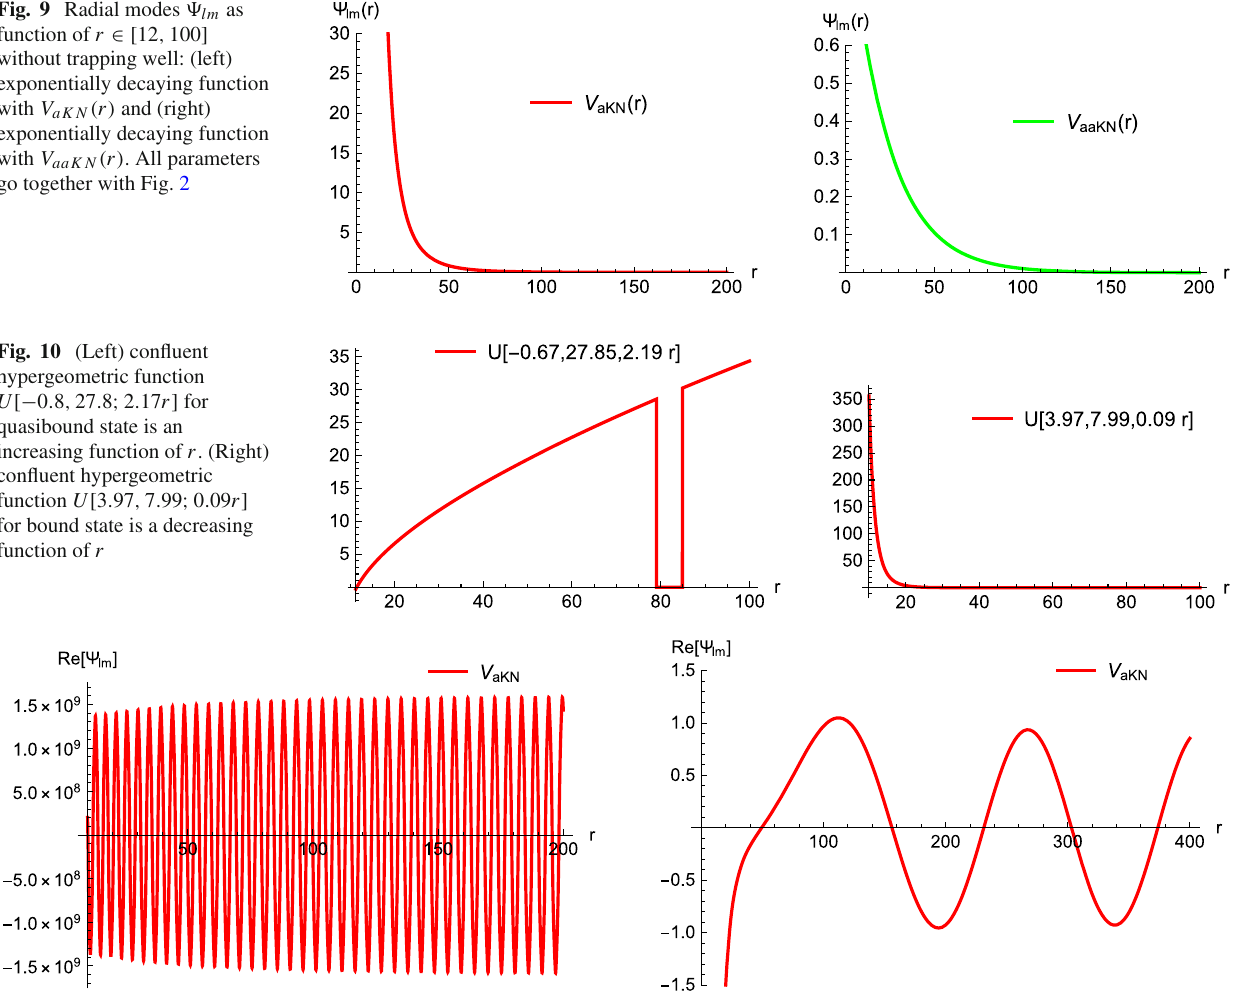
Fig. 11 (Left) real part of (cid:13) lm ( r ) as function of r ∈ [ 10 , 200 ] where all parameters go together with Fig. 7 except ω = 4 > μ = 3 . 85. (Right) real part of (cid:13) lm ( r ) as function of r ∈ [ 10 , 400 ] where all parameters go together with Fig. 3 except ω = 0 . 05 > μ = 0 .